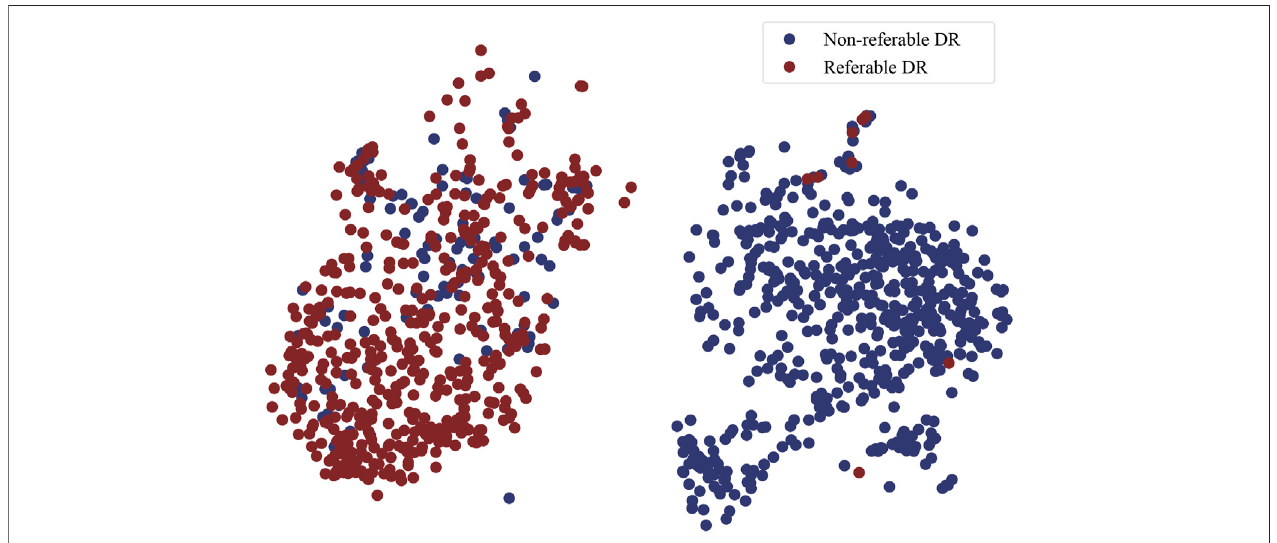
FIGURE 5 | The t-SNE plot of DR classi fi cation on the APTOS 2019 dataset.